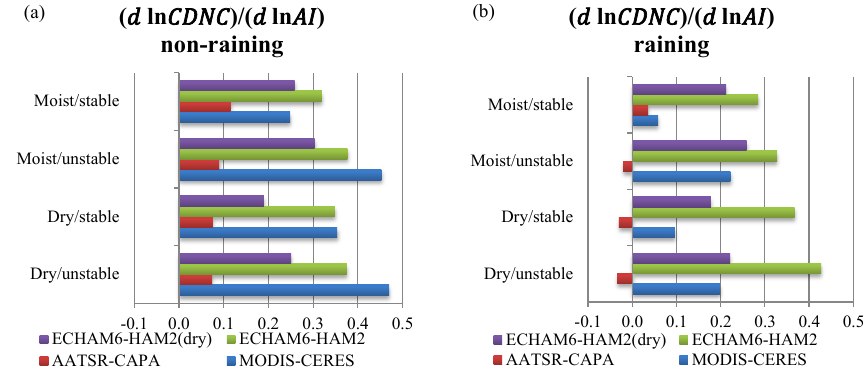
Figure 3. Susceptibility of CDNC to changes in AI for ECHAM6-HAM2 (E6_Ref), E6_Ref without aerosol water uptake (dry) during 1995–2012, for AATSR–CAPA using the full satellite record span 2002–2012 and for MODIS–CERES during 2006–2010. The definitions of the different environmental regimes are given in the text. (a) For all non-raining scenes, (b) for all raining scenes. Only values averaged over global oceans are shown. The MODIS–CERES data are from Christensen et al.